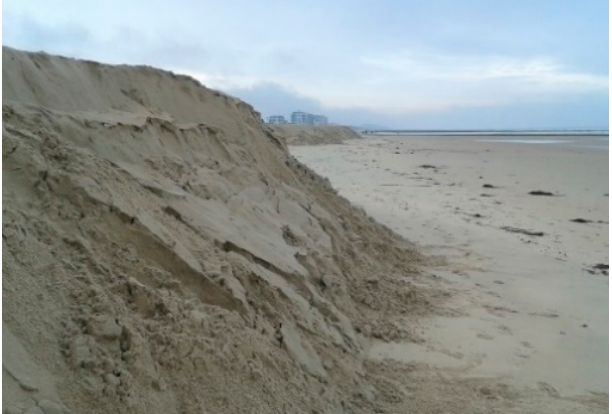
Figure 13. Ground photograph of the berm following the high water of 12 November.